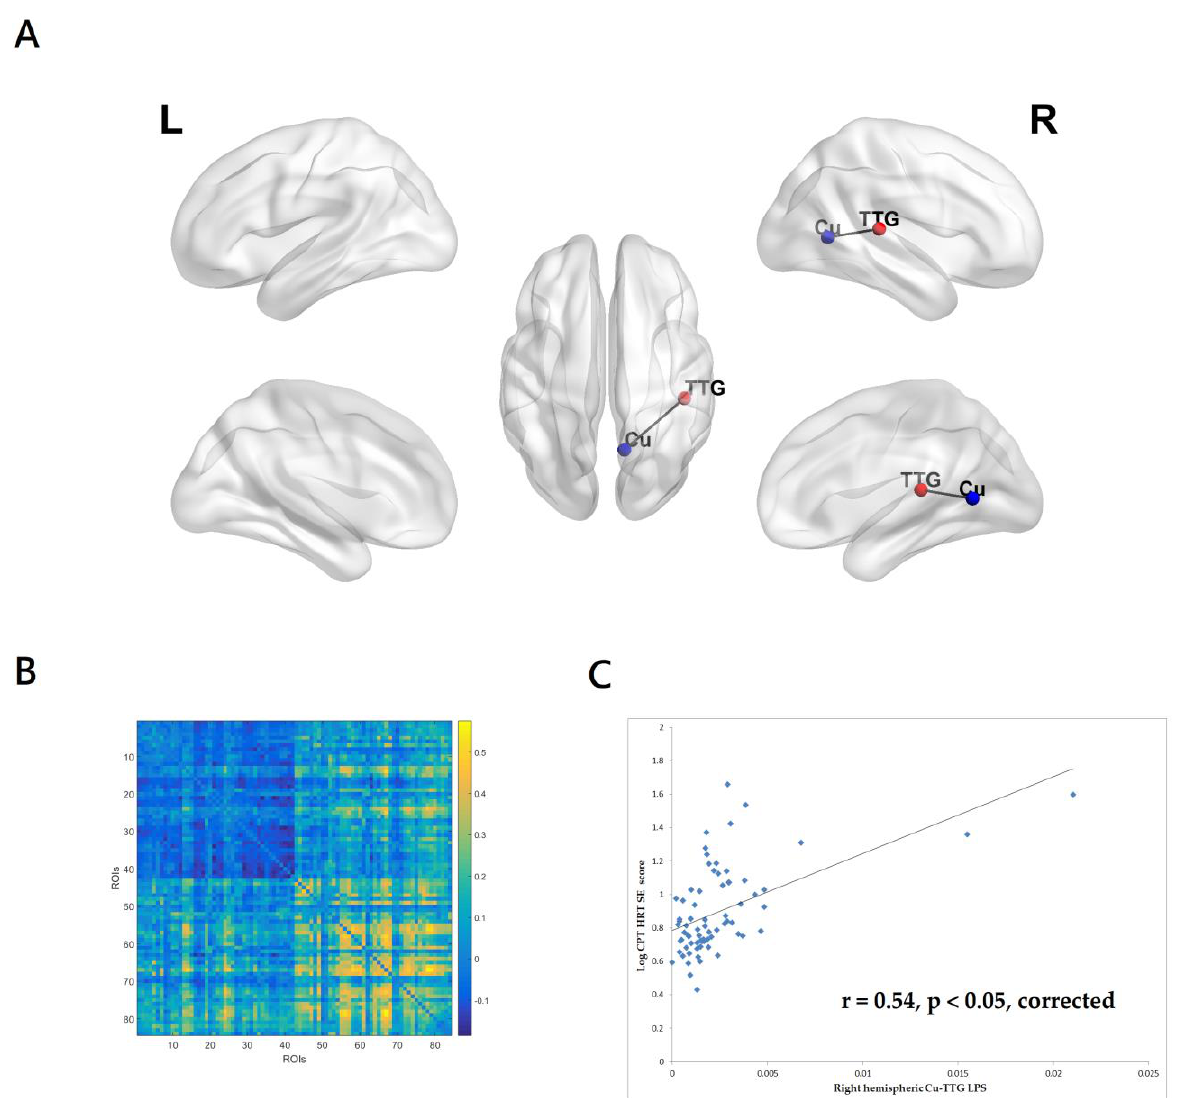
Figure 3. ( A )The CPT-II HRTSE score was significantly associated with the gamma-band (33–45 Hz) LPS between right hemispheric cuneus (Cu) and transverse temporal gyrus (TTG). eLORETA and BrainNet Viewer were used to create the figure. ( B ) The matrix of the correlation coefficients for the value of gamma-band lagged phase synchronization (LPS) of all pairs from 84 regions of interest. ( C ) The patients with higher CPT-II HRTSE scores had greater gamma-band EEG functional connectivity between right hemispheric Cu and TTG. The linear regression line was shown to model a linear trend seen in the scatterplot.